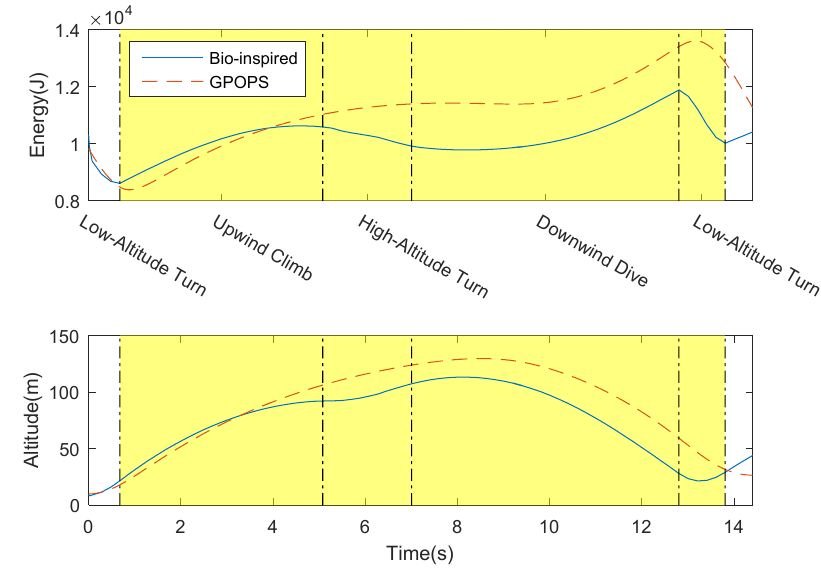
Figure 16. Time histories of energy and altitude for the Gauss Pseudospectral Optimization Software (GPOPS) and proposed bio ‐ inspired methods.